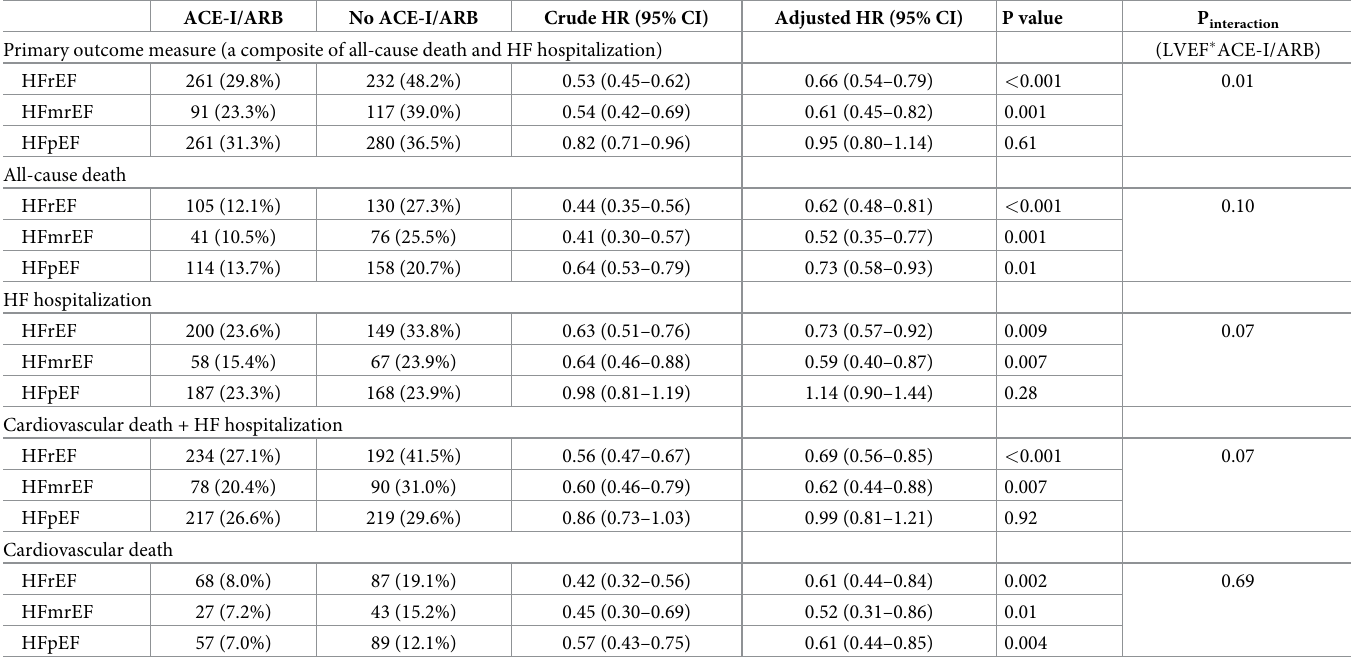
Table 3. Effects of the use of ACE-I/ARB on clinical outcomes according to the LVEF